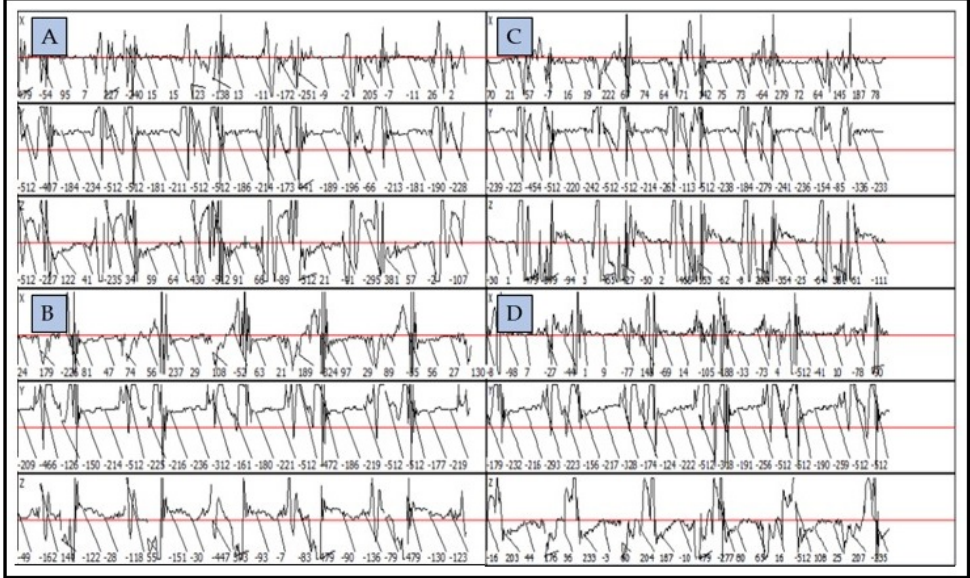
Figure 2. Graphic representation of the gait analysis as recorded and processed by the Lameness Detector 0.1 for the four legs of a horse: right fore ( A ), right hind ( B ), left fore ( C ), and left hind ( D ), showing both the values of acceleration (m/s 2 ) and trajectory of the accelerometer on its three axes. On each of the three axes, the acceleration values were shown in m/s 2 and the trajec- tory of the sensor was displayed graphically (Figure 2). This representation allowed the comparisons between the lame and the sound contralateral